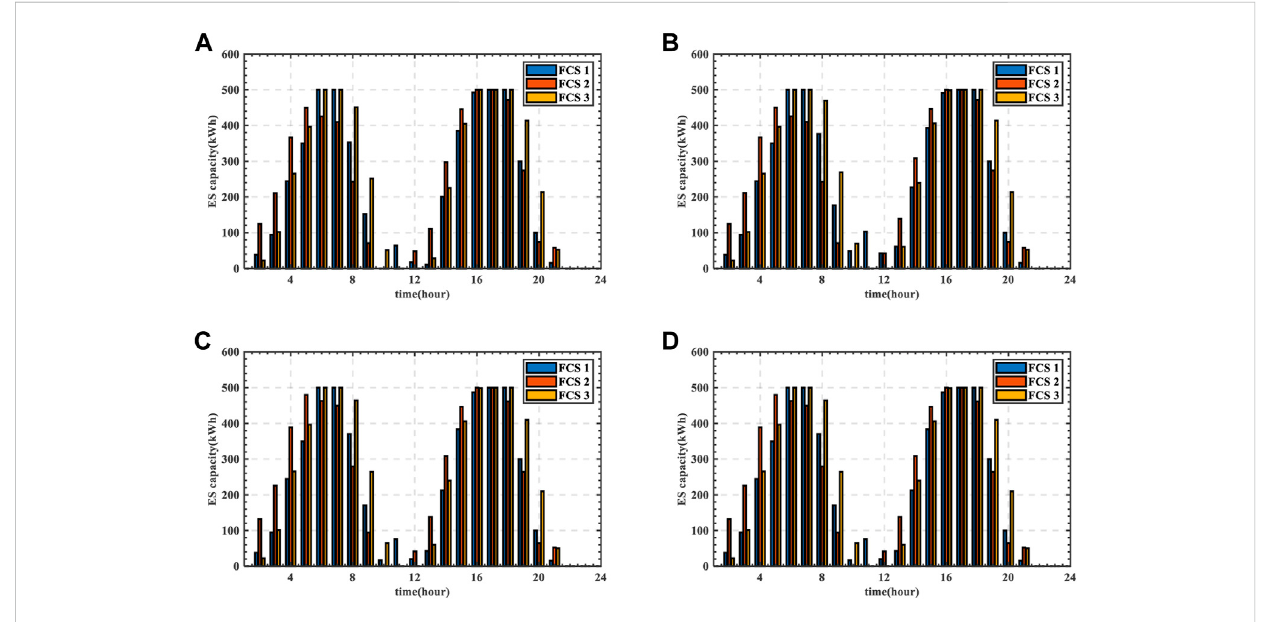
FIGURE 17 ES operation status of scenario two for the shortest travel time path.